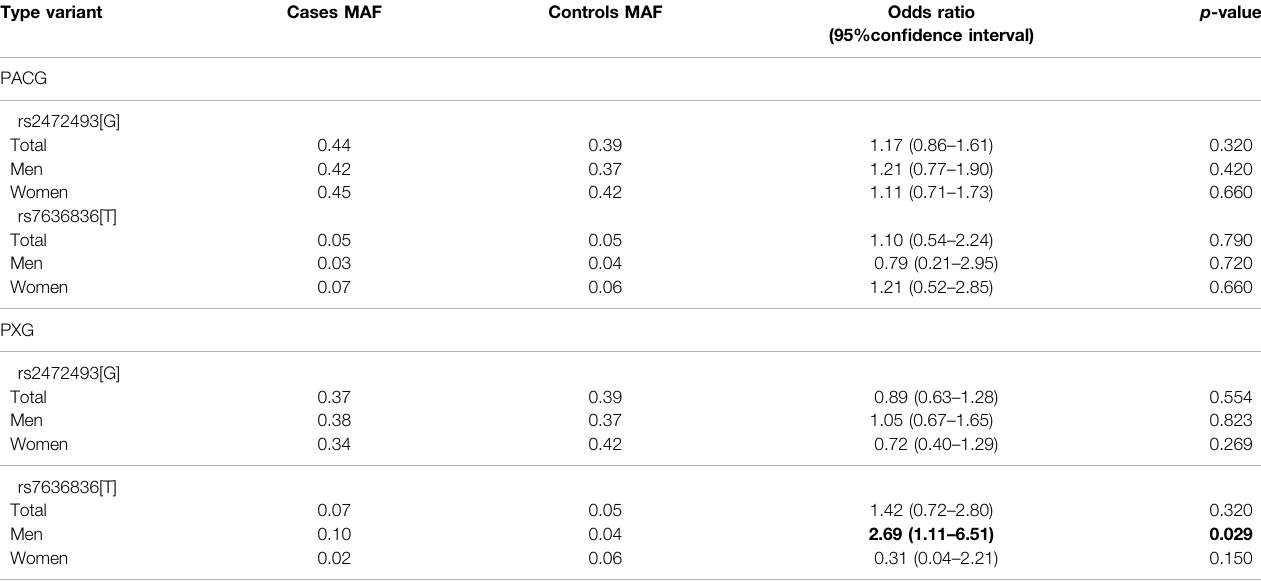
TABLE 1 | Minor allele frequency of rs2472493 in ABCA1 and rs7636836 in FNDC3B genes according to glaucoma types and gender.